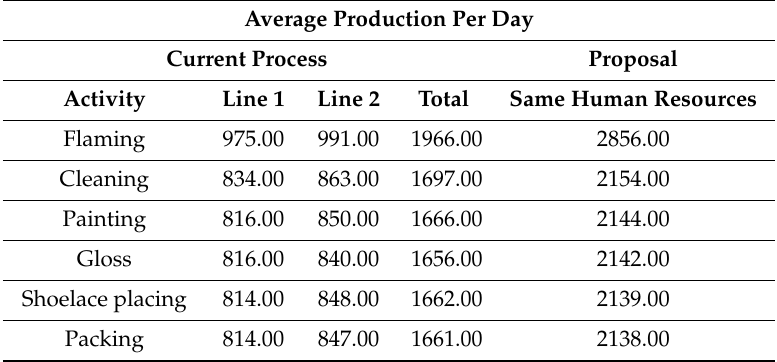
Table 5. Comparison of process indicators, average production per day: Current-Proposal.